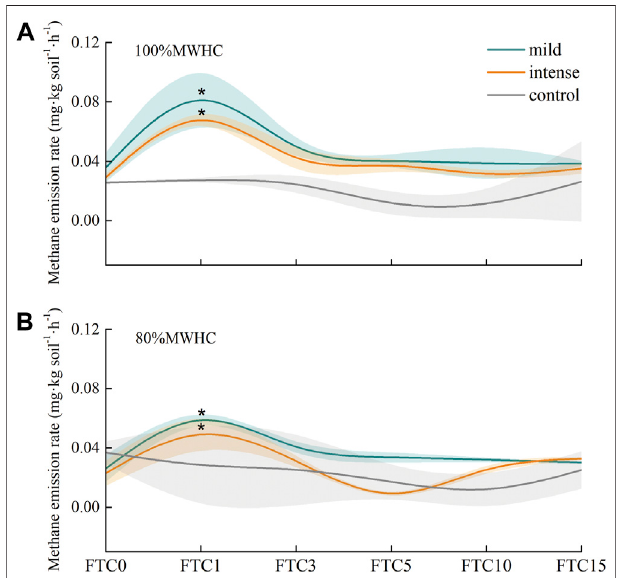
FIGURE 2 | Methane emission rate in freeze – thaw cycles. (A) The methaneemissionratesof100%MWHCpeat; (B) themethaneemissionrates of 80%MWHC peat. Mild means freeze – thawcycle at − 5~4 ° C; intense means freeze – thawcycleat − 15 – 4 ° C;*,thereisasigni fi cantdifferencebetween freeze – thaw peat and control group ( p < 0.05).